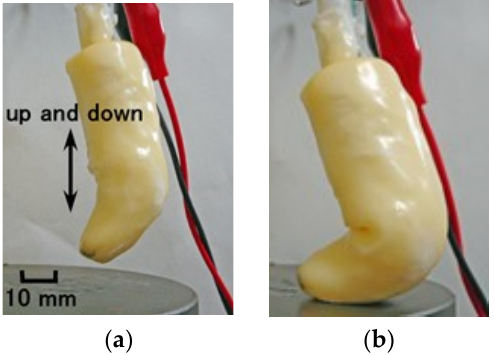
Figure 15. Photographs of the soft bending finger: ( a ) before touching; ( b ) upon touching.